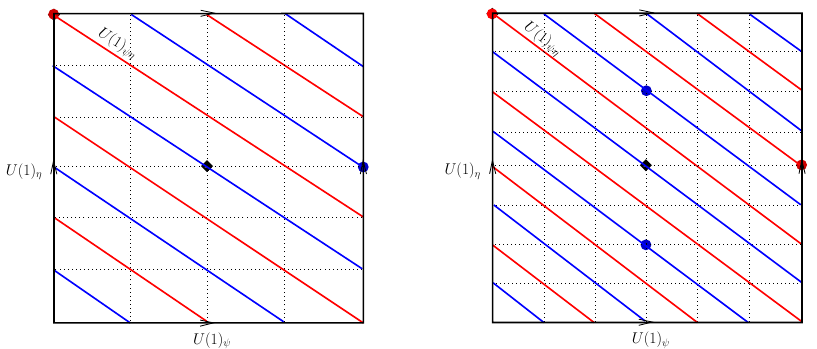
Figure 2 . The torus U(1) (cid:2) U(1) (cid:17) (for N = 2 on the left and N = 4 on the right) and its unbroken subgroup U(1) (cid:17) (cid:2) ( Z 2 ) F (red line for U(1) (cid:17) (cid:2) f 1 g and blue line for U(1) (cid:17) (cid:2) f(cid:0) 1 g ) passing through all the points of the lattice ( Z N +2 ) (cid:2) ( Z N +4 ) (cid:17) . The dots indicate the elements of the group ( Z N ), diamonds indicate the elements of ( Z 2 ) F . ( Z 2 ) F is de(cid:12)ned below, eq.